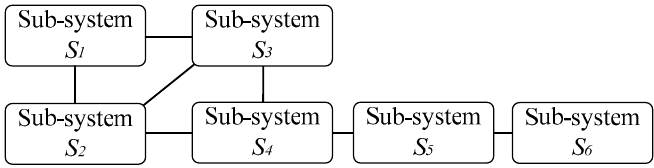
Figure 7. Topology of the IEEE 118-bus sub-systems.